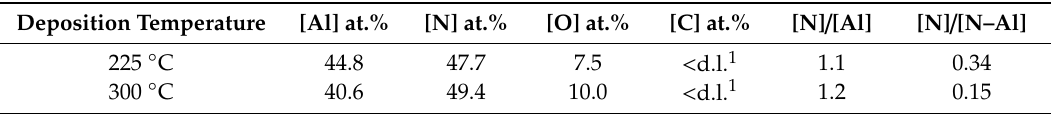
Table 1. Chemical composition of the AlN films deposited at 225 and 300 ◦ C as determined by high resolution XPS analysis.